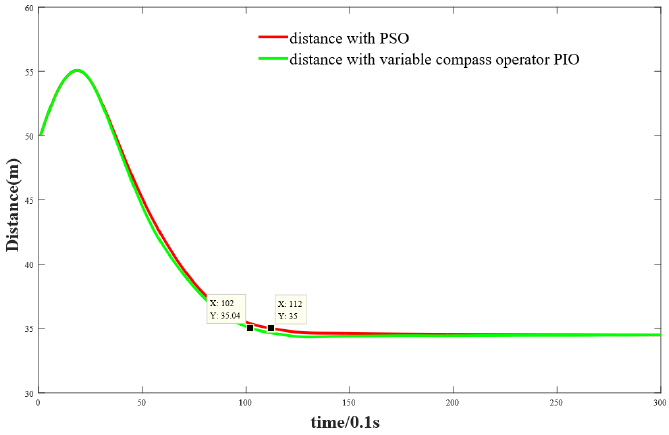
Figure 3. Distance curves for PSO and variable compass operator PIO.